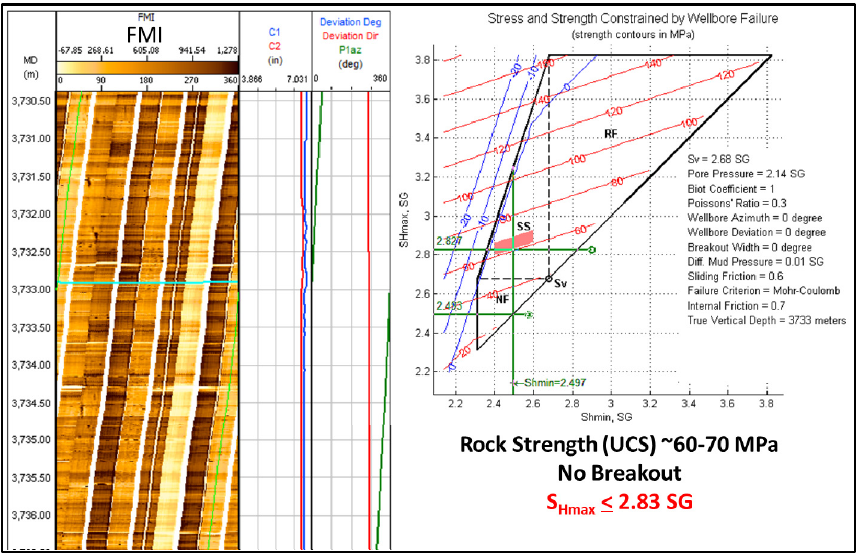
Figure 17. S Hmax magnitude determination of W206 at 3733 m true vertical depth (TVD).